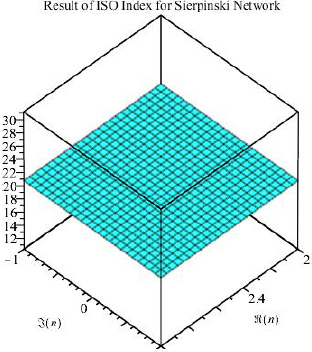
Figure 12. Result of ISO index for Sierpinski network S n .